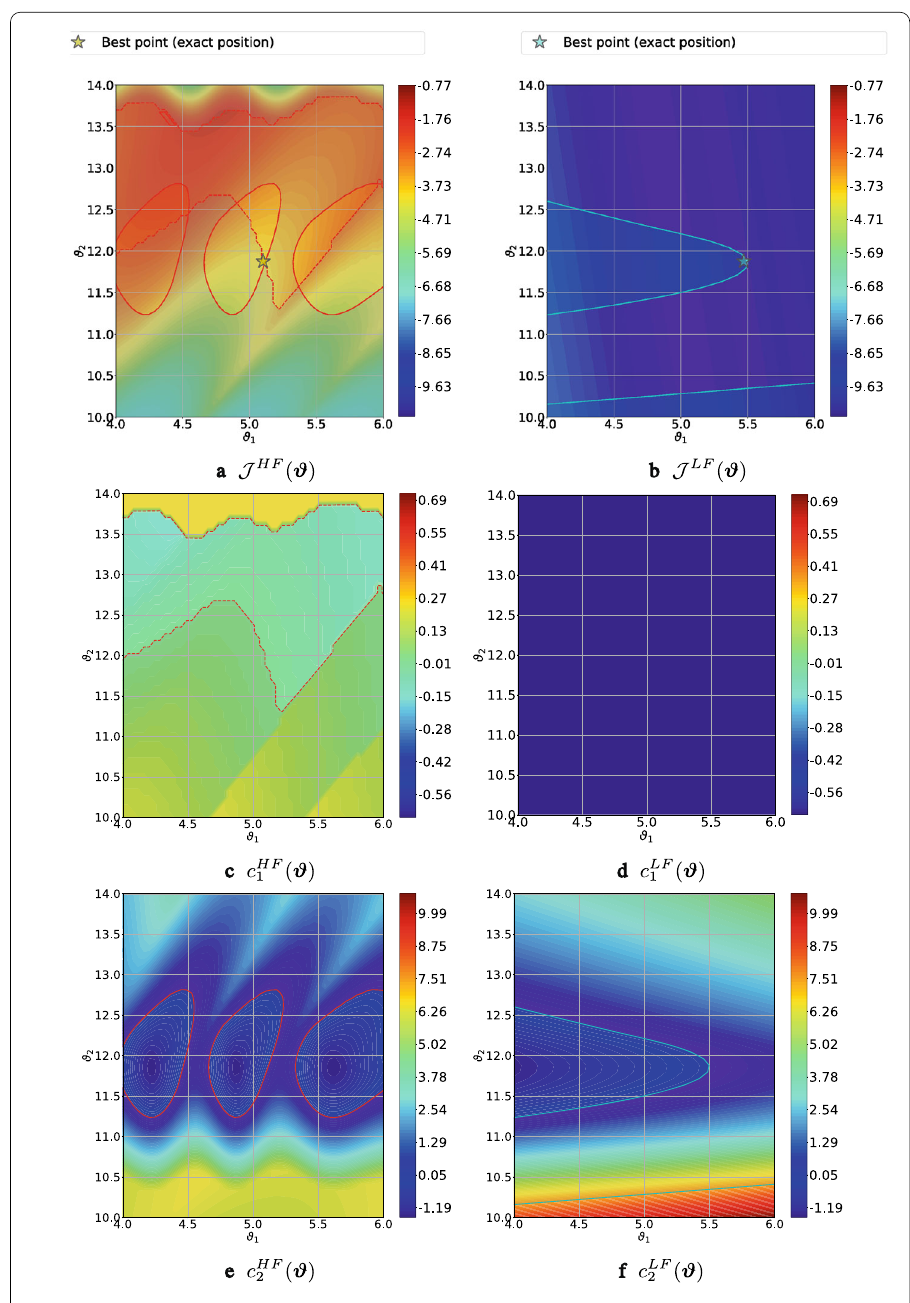
Fig. 2 Values of the objective function (first row) and of the constraints functions c 1 (second row) and c 2 (third row) of HF (left column) and LF (right column)